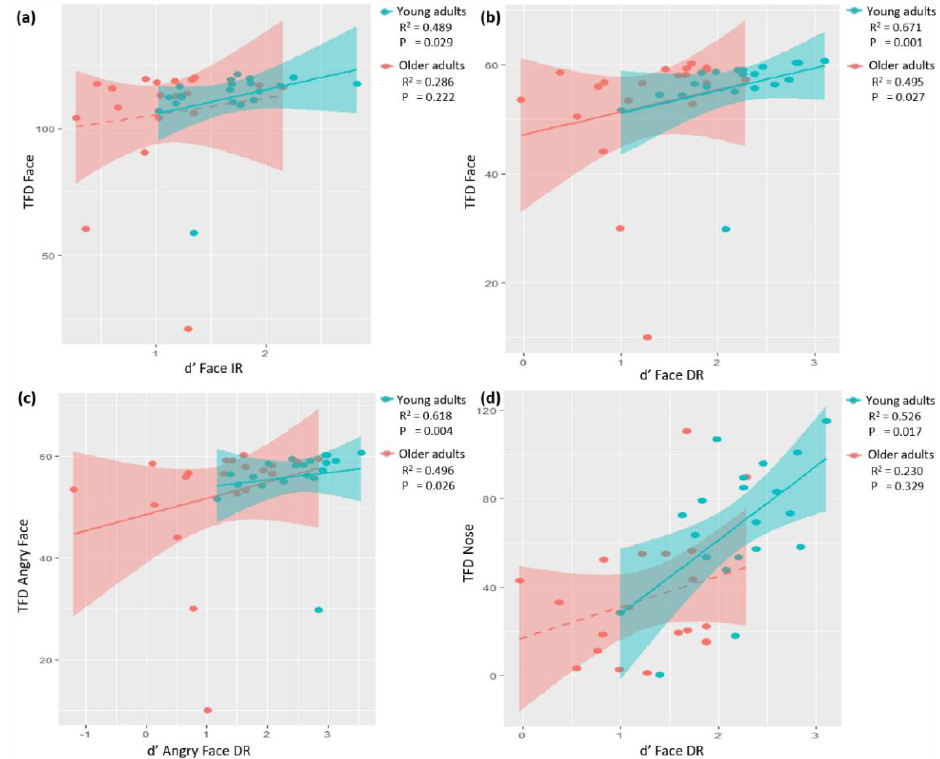
Figure 6. Scatterplots presenting the relation between total fixation duration (TFD) and d’s. ( a ) Correlation between total fixation duration (TFD) for faces and d’ for faces in IR, where only the young adults group reached statistical significance (r = 0.489, p = 0.029). ( b ) Correlations between total fixation duration (TFD) for faces and d’ for faces in DR are significant in both groups (young adults: r = 0.671, p = 0.001; older adults: r = 0.495, p = 0.027). ( c ) Correlations between total fixation duration (TFD) for angry faces and d’ for angry faces in DR are significant in both groups (young adults: r = 0.618, p = 0.004; older adults: r = 0.496, p = 0.026). ( d ) Correlations between total fixation duration (TFD) for nose and d’ for faces in DR, where only the young adults group reached statistical significance (r = 0.526, p = 0.017). Solid lines represent a significant correlation; dashed lines represent a non-significant correlation.